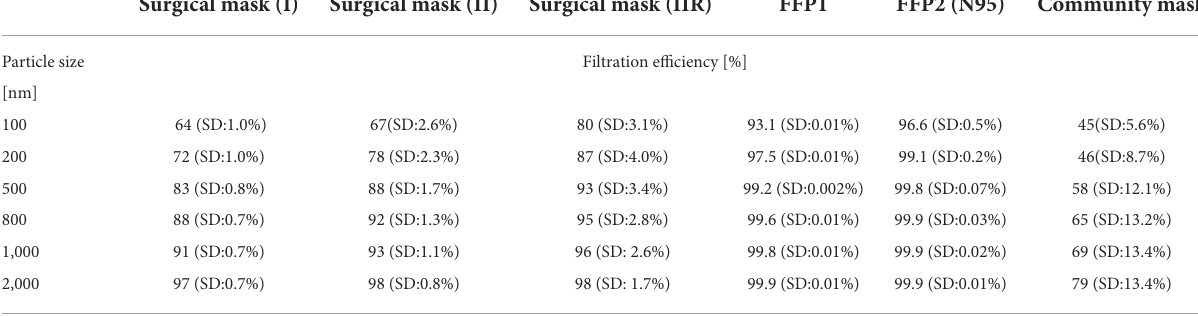
TABLE 4 Filtration efficiency of different types of masks. Surgical mask (I) Surgical mask (II) Surgical mask (IIR) FFP1 FFP2 (N95) Community mask